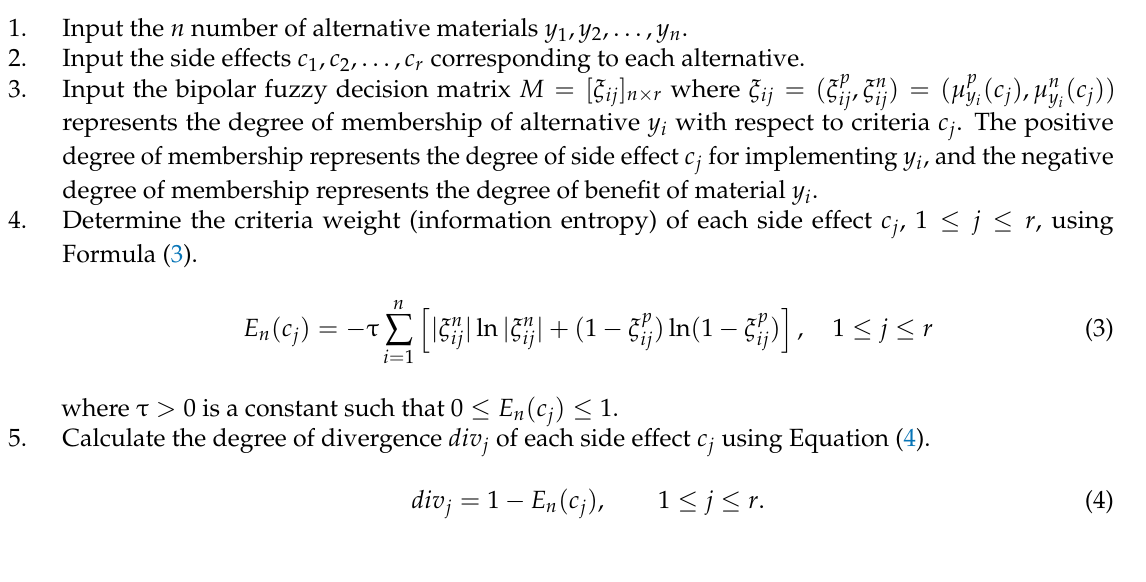
Algorithm 4. Bipolar fuzzy extended TOPSIS method based on entropy